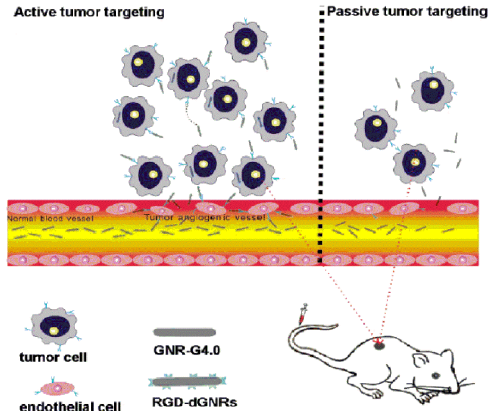
Figure 5. The possible therapeutic mechanism of RGD-dGNR nanoprobes. Reprinted with permission from ([23]). Copyright (2010) American Chemical